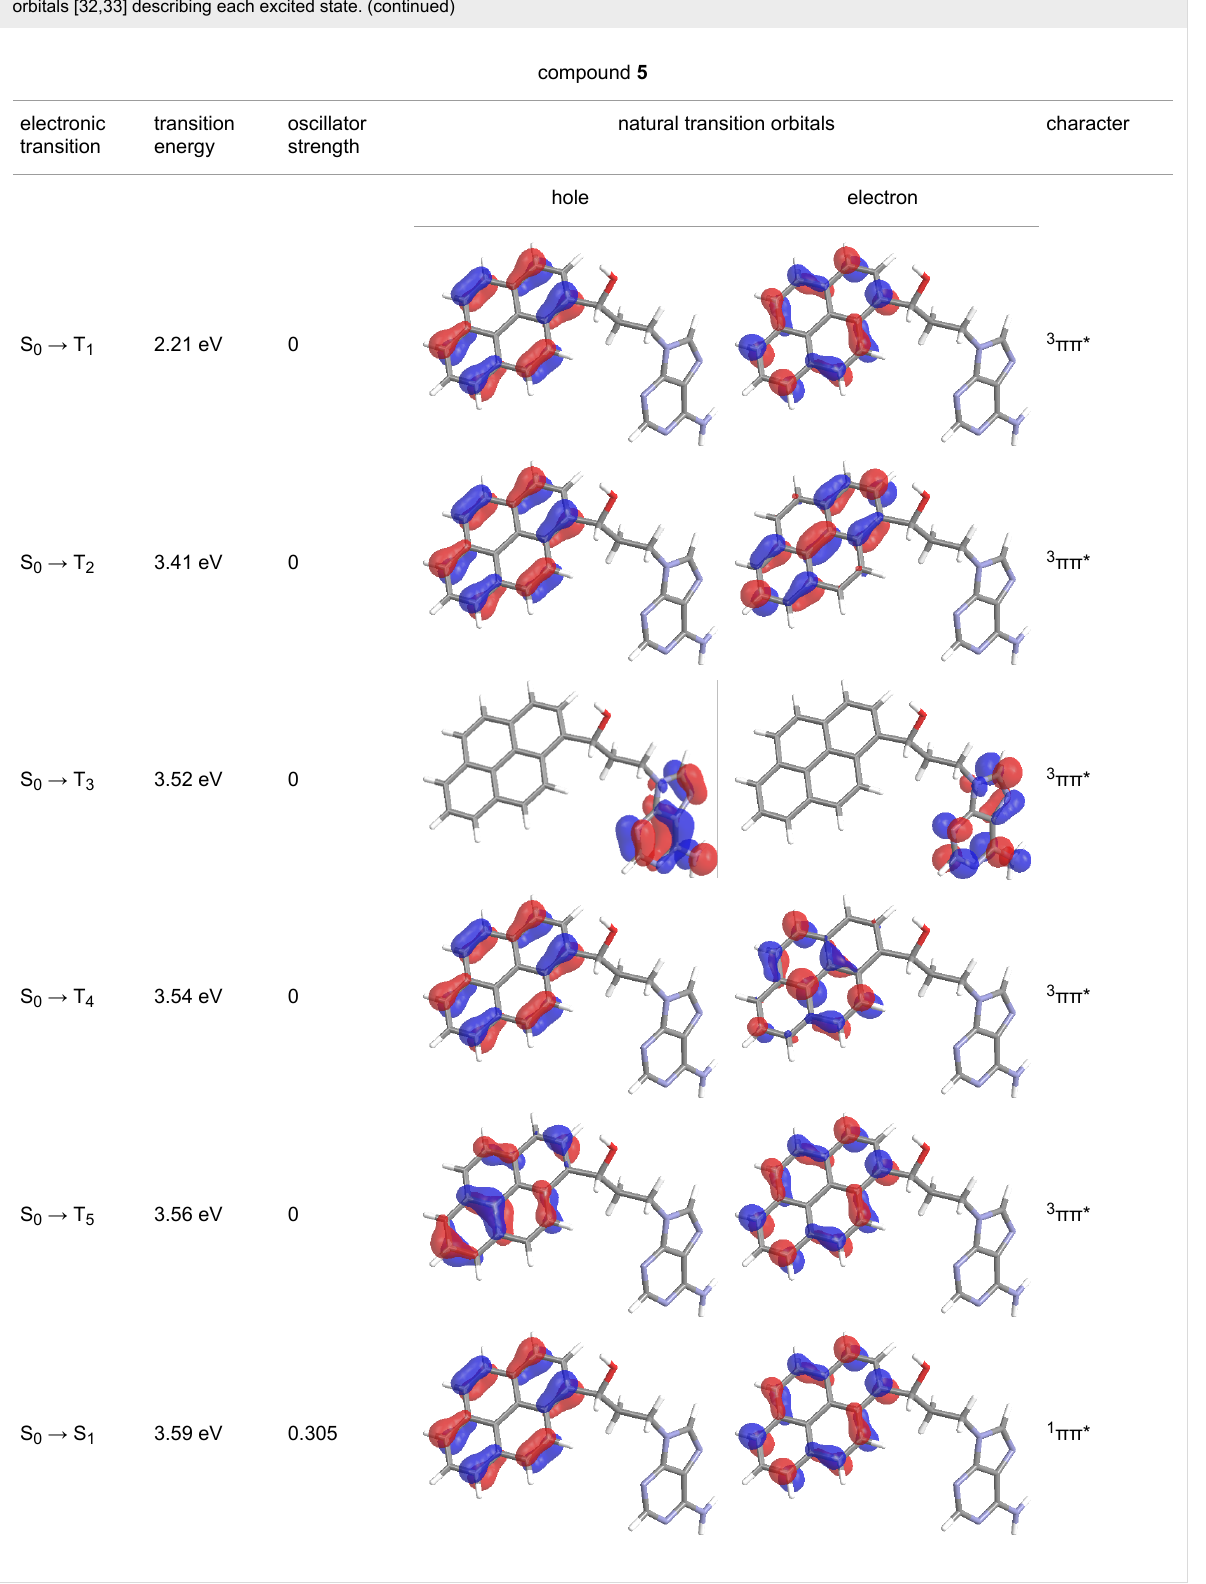
Table 2: Selected lowest-energy vertical electronic transitions resulting from TD-DFT calculations for pyrene–adenine conjugates 3 and 5 in the ground state geometry at the B3LYP/6-311G(d,p) theory level. “Holes” (starting orbitals) and “electrons” (final orbitals) represent natural transition orbitals [32,33] describing each excited state.